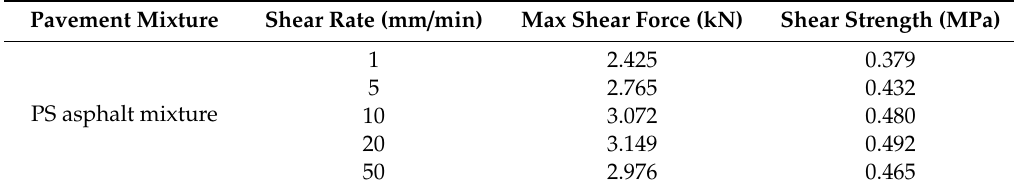
Table 7. Results of interlaminar shear strength tests at di ff erent shear rates.